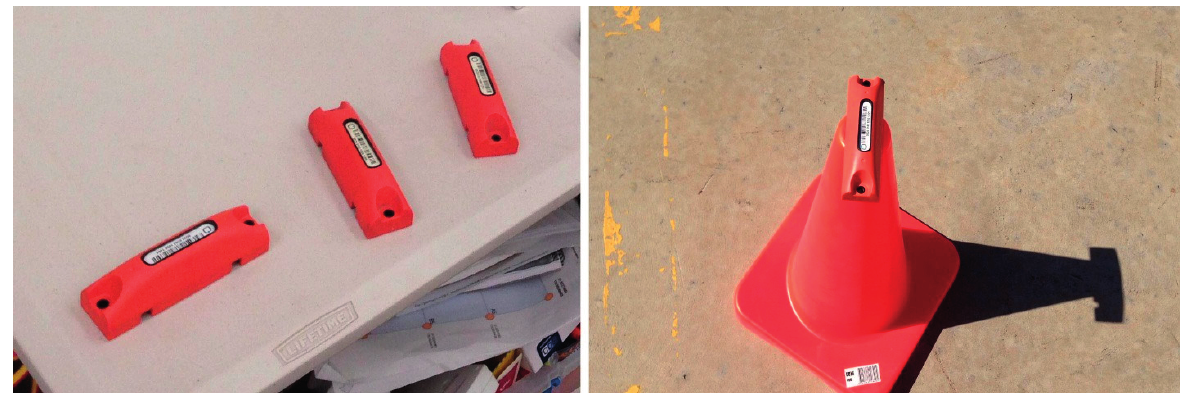
Figure 4. Example of the RFID tags used in this